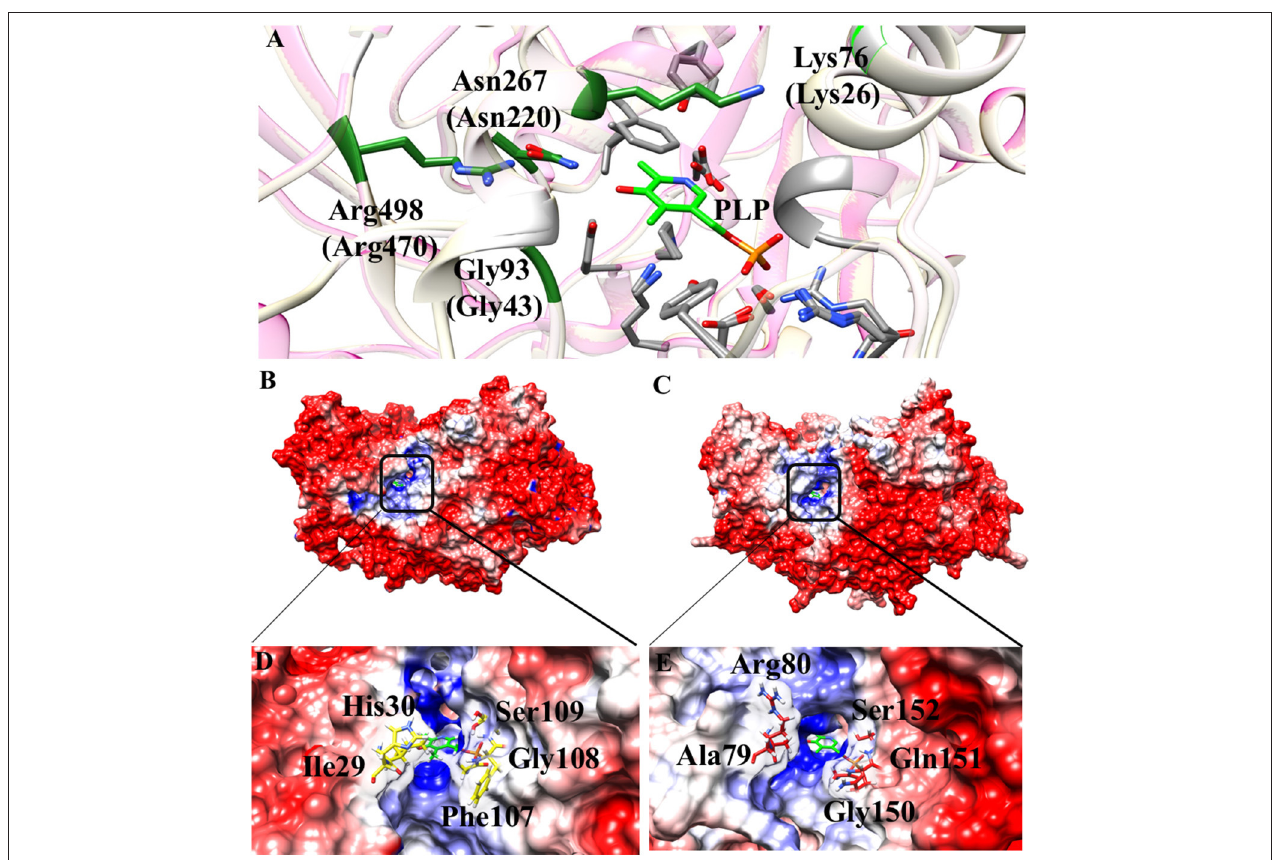
FIGURE 8 | Structural features of the AroH active site regions. (A) Ribbon representation of superimposition of the region surrounding the active site in AroH and Aro8. Residues involved in PLP or substrate binding are highlighted as gray or green sticks, respectively. The PLP cofactor is shown as light green stick. (B,C) Electrostatic surface potential of Aro8 (B) and AroH (C) calculated using non-linear Poisson Boltzmann equation [ − 4 (red) and + 4 (blue) kT/e] at 25 ◦ C, pH 7.4. (D,E) Particular of the electrostatic map of the active site channel of Aro8 (D) and AroH (E) . Residues involved in the formation of active site channel of Aro8 are highlighted as sticks. Around the sticks transparency (80%) of the surface representation has been applied. Potential contours are [ − 4 (red) and + 4 (blue) kT/e] around both proteins.